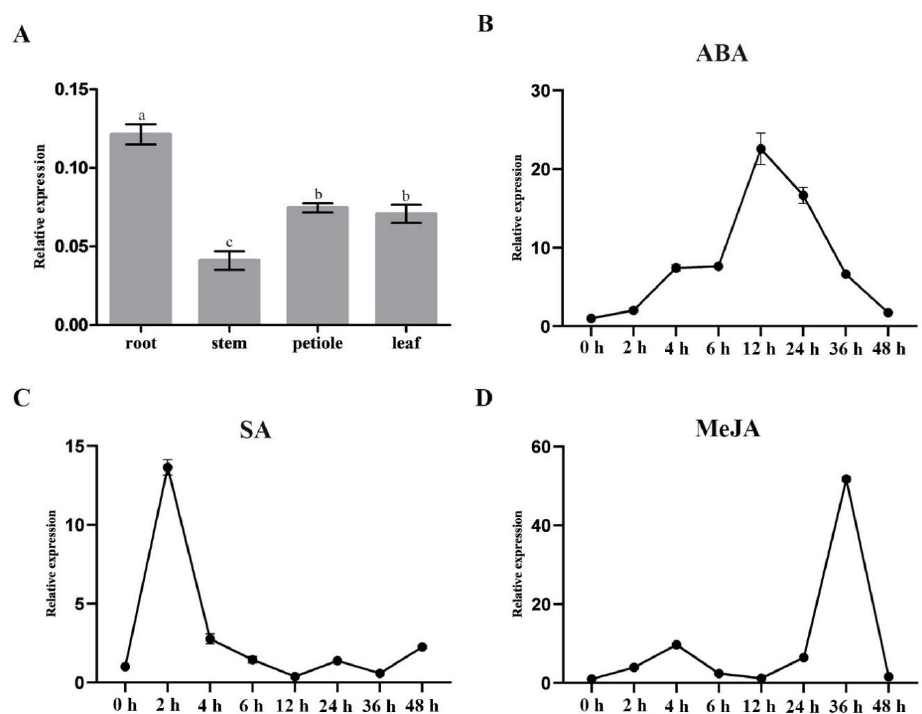
Figure 3. Expression profile of NoMYB60 gene in watercress. ( A ) NoMYB60 expression levels in different tissues (root, stem, petiole and leaf). The error lines represent the standard errors, different letters represent significant differences, p < 0.05. ( B – D ) expression analysis of NoMYB60 under respect ABA, SA and MeJA treatments. Watercress, cut to a length of about 15 cm, was exposed to ABA (5 mg/L), SA (5 mg/L) and MeJA (1 mg/L) treatments over a consecutive time course (0, 2, 4, 6, 8, 12, 24, 36 and 48 h). The horizontal axis represents processing times and the vertical axis represents the relative expression.